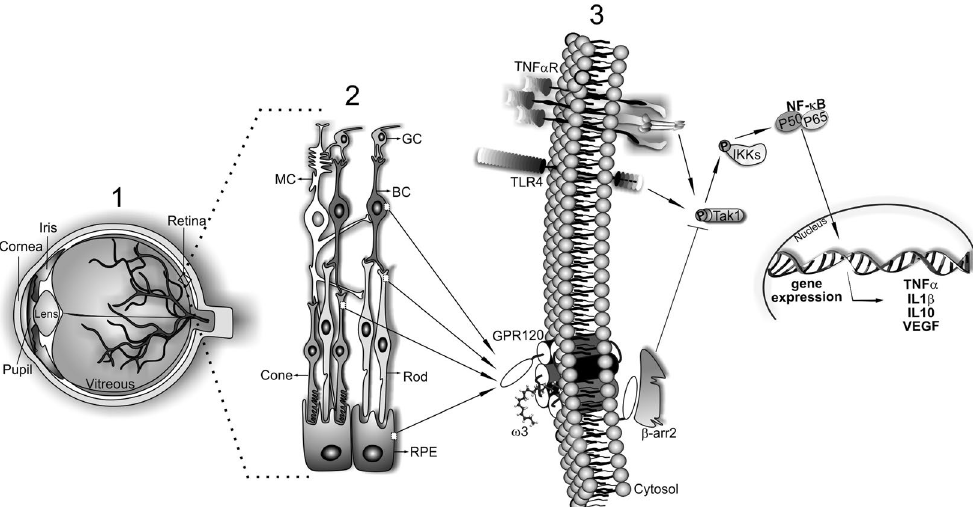
Figure 6. Graphical Abstract. (1) The general eye structure. (2) The main cellular types involved in the retinal structure: MC microglial cells; GC ganglion cells; BC bipolar cells; RPE retinal pigmented cells; Cones and Rods. (3) The pro-inflammatory signaling triggered by both TLR4 or cytokine receptors such as TNF α activates Tak1. These proteins recruit three Tab monomers, which phosphorylates and activates Tak1. Tak1 is a nodal molecule responsible to activate the inhibitor of kinase kappa (IK κ ) and consequently the canonical pro- inflammatory pathway orchestrated by NF- κ B. On the other hand, omega-3 fatty acid from flaxseed oil activates GPR120 receptor in the cell membrane. GPR120 recruit beta-arrestin2 protein which detached the protein complex formed by Tab and Tak1 inhibiting the pro-inflammatory